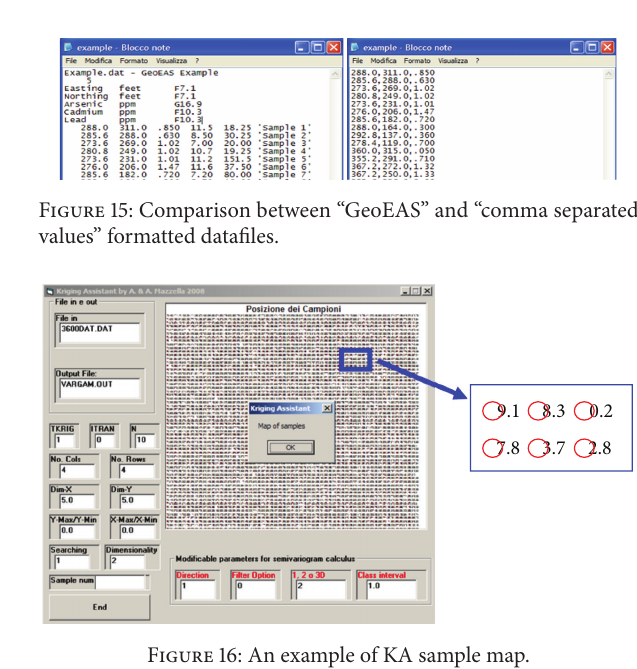
Figure 16: An example of KA sample